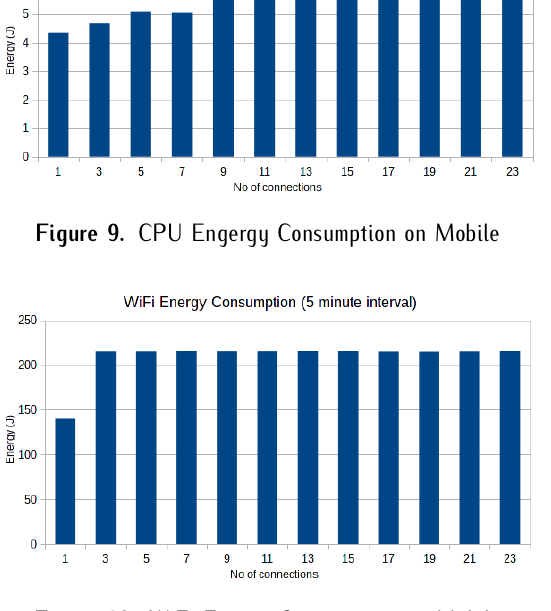
Figure 10. WiFi Energy Consumption on